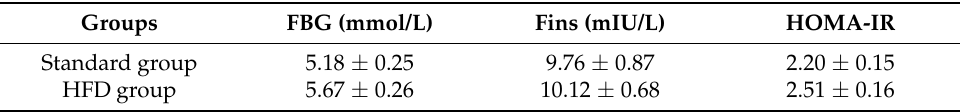
Table 1. Homoeostasis model assessment of insulin resistance (HOMA-IR) assay at 15 weeks of age (mean ±